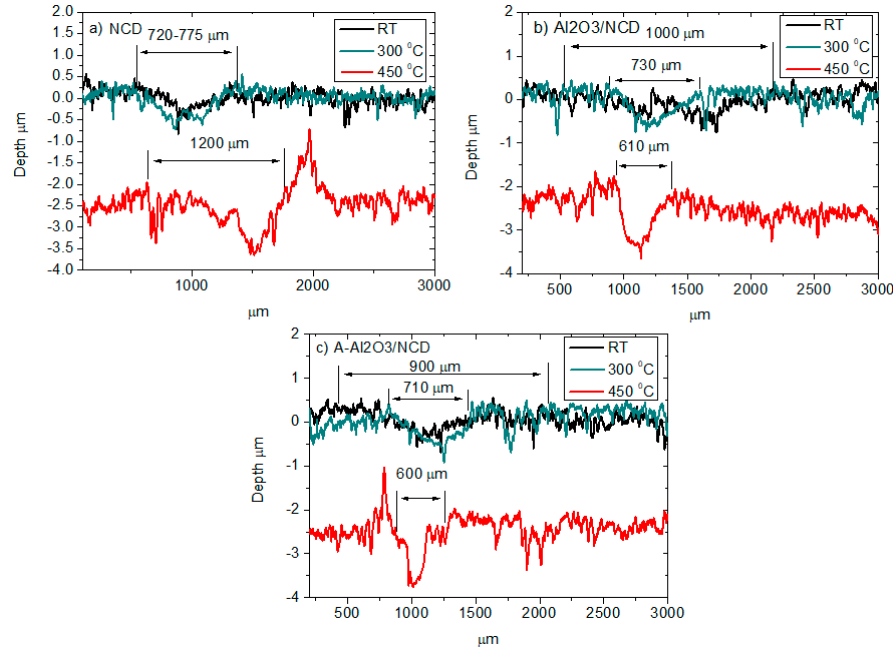
Figure 6. Line scans across the wear scars taken on the ( a ) NCD, ( b ) Al 2 O 3 /NCD and ( c ) A-Al 2 O 3 /NCD films.